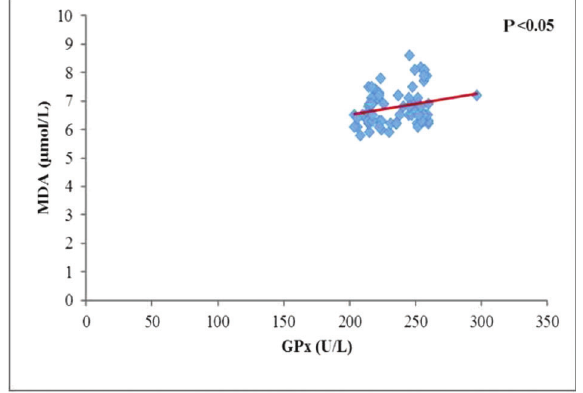
Figure 1. Correlation between lipofuscin-like fl uorophores (LLF) and myeloperoxidase (MPO) in serum of patients with hypertension and age-related cataract (n=69, r=0.255, P o 0.05).